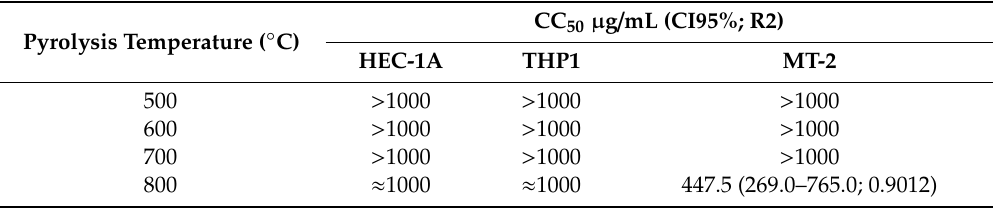
Table 2. Results of the cytotoxicity analysis of the materials tested in MT-2, THP-1 and HEC-1A cells. Cytotoxic Concentrations 50 (CC 50 ) were calculated using GraphPad Prism software.